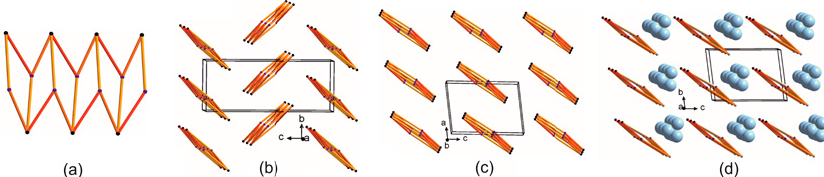
Figure 15. Simplified hydrogen-bonded networks in perindopril erbumine structures: a ladder LSAM ( a ); packing of LSAMs in orthorhombic ( b ) and monoclinic ( c ) polymorphs and hydrate ( d ). The black and gray dots represent a center of gravity of crystallographically independent ions, orange-shaded lines stand for O-H … O or N-H … O hydrogen bonds, water molecules are represented as blue spheres.